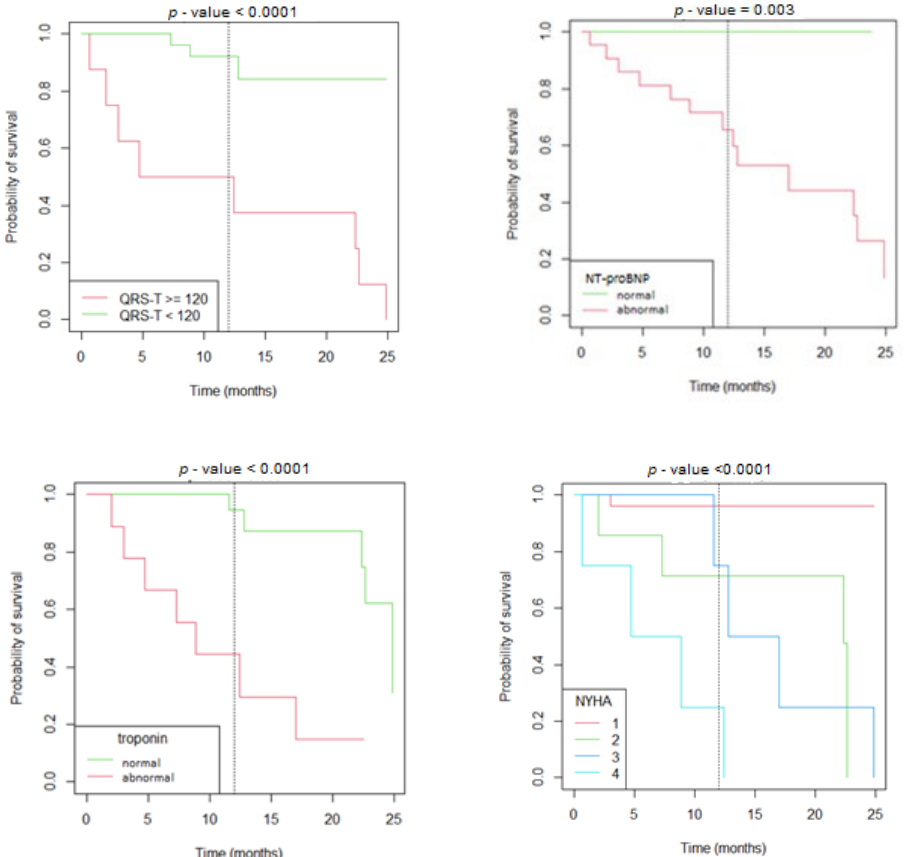
Figure 1. Kaplan–Meier survival curves according to the value of the QRS-T angle, serum concen- trations of NT-proBNP and troponin, and NYHA/Ross